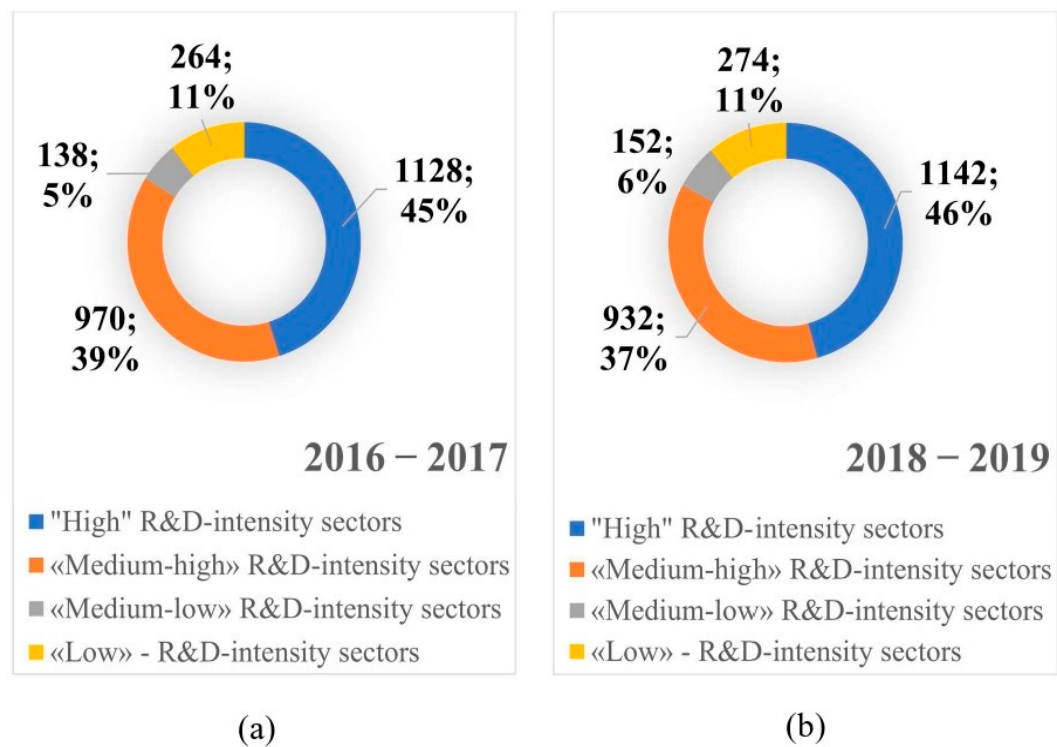
Figure 1. ( a ) R&D intensity by industry sector in 2016-2017; ( b ) R&D intensity by industry sector in 2018–2019. Source: drawn up by [54,55].